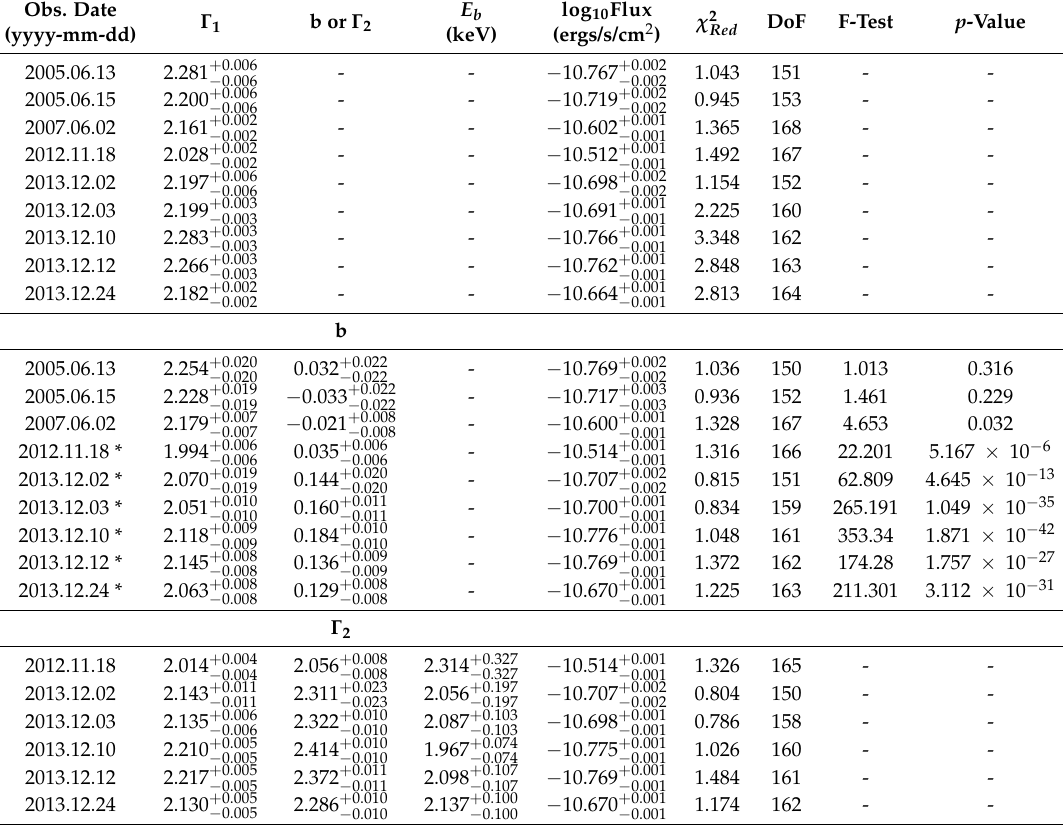
Table 4. Best spectral fit parameters for the Power Law, Log Parabolic and Broken Power Law Model for XMM-Newton Observations of Blazar H 2356-309.